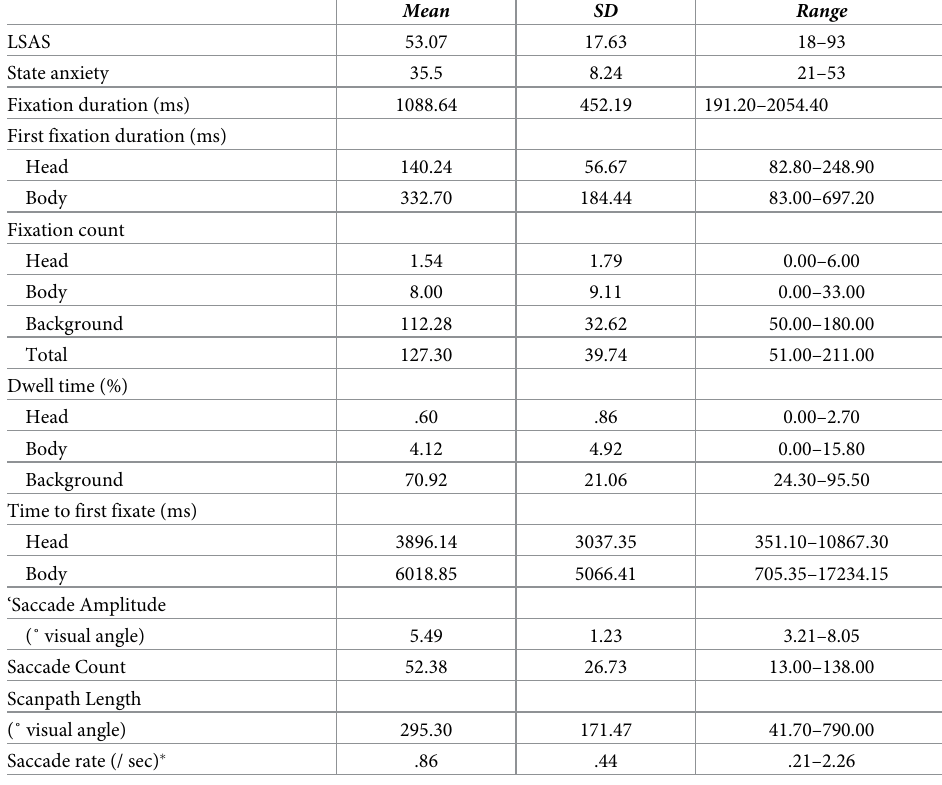
Table 1. Descriptive statistics for anxiety and eye-tracking